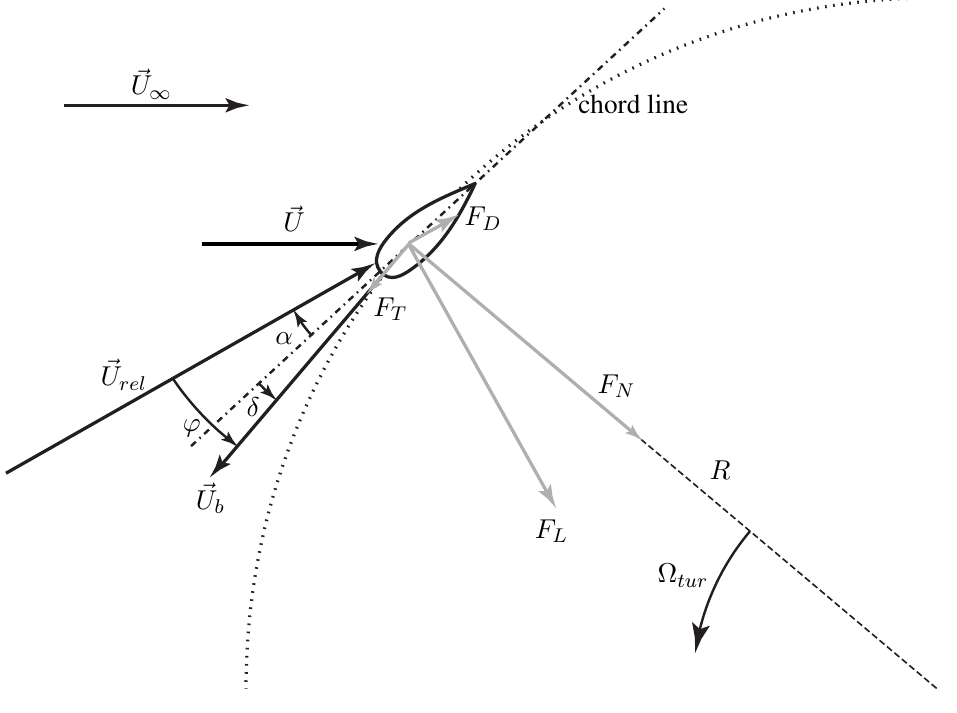
Figure 1. Notation of the velocities and forces acting on the blade of a VAWT. Note that in this paper, the positive direction of F